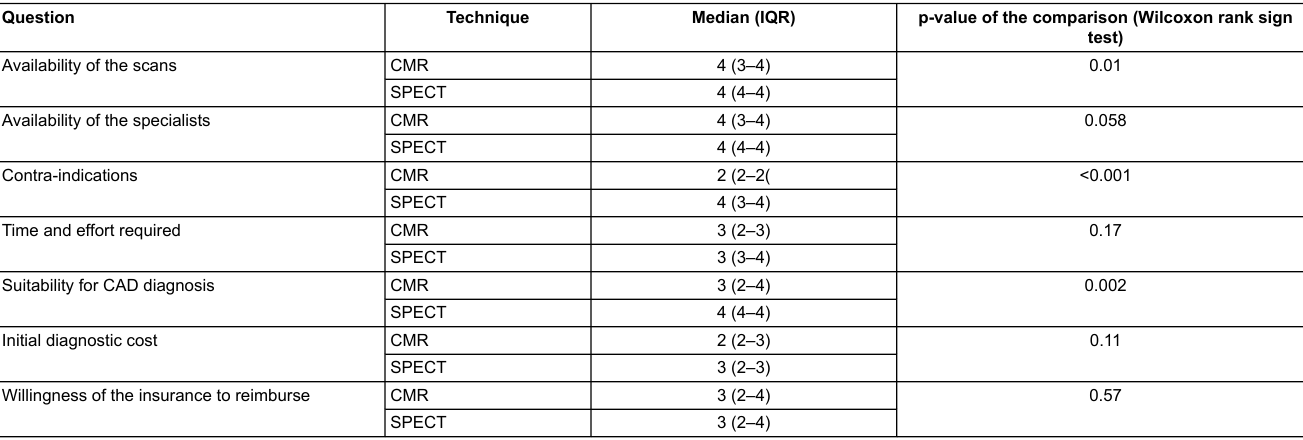
Table 2: Median score of each question with interquartile